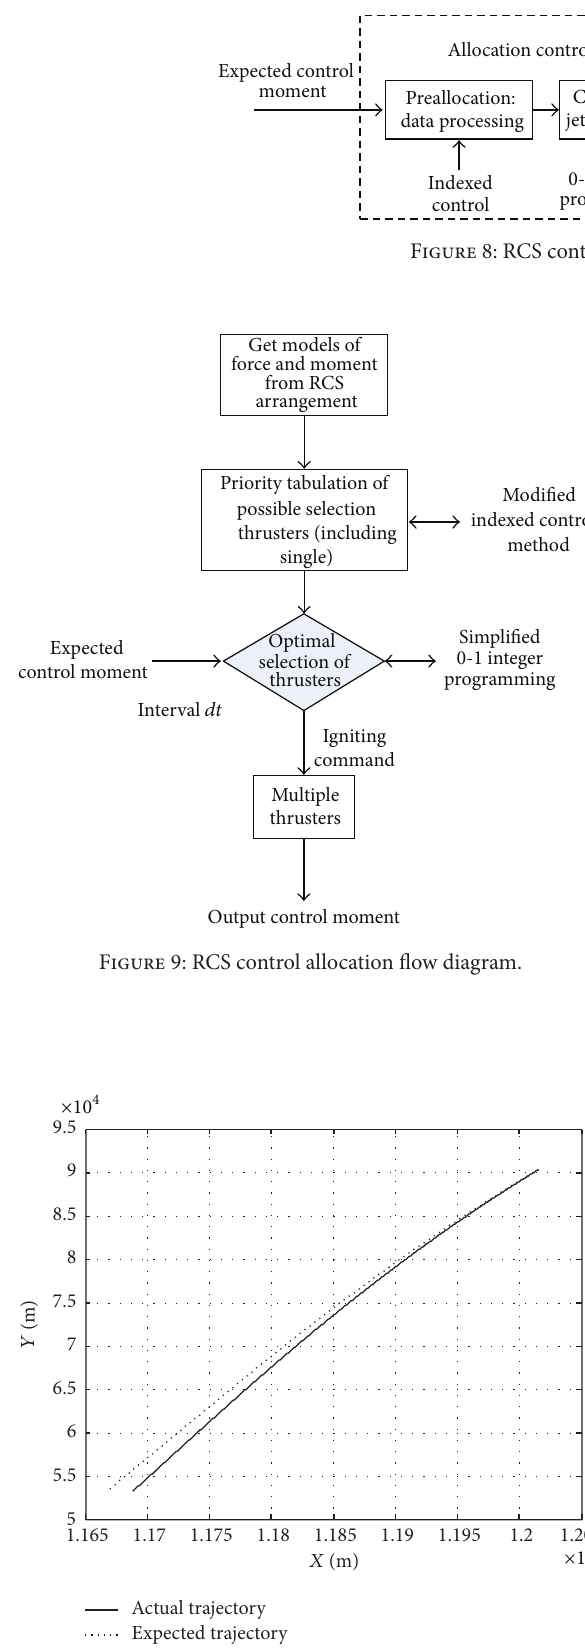
Figure 10: Simulation result of trajectory in 2D.